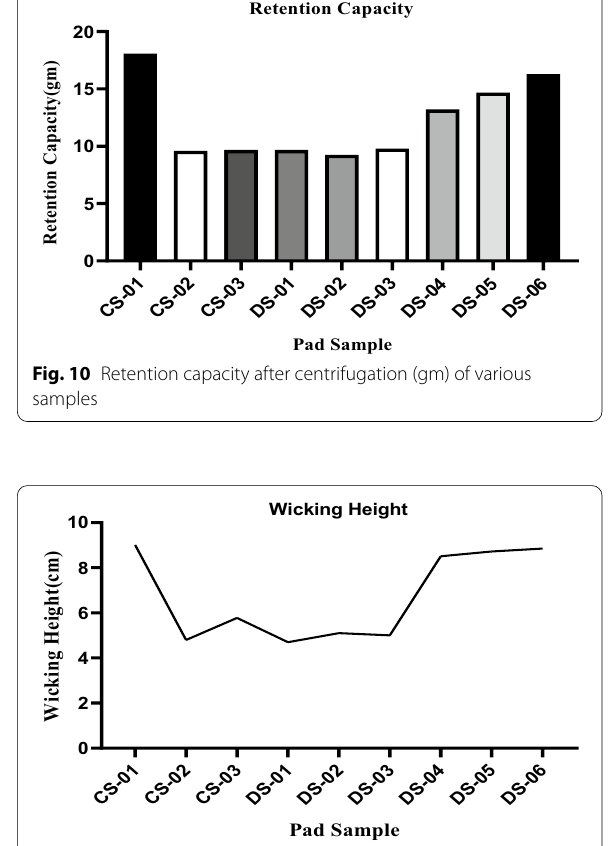
Fig. 11 Wicking height (cm) of various samples